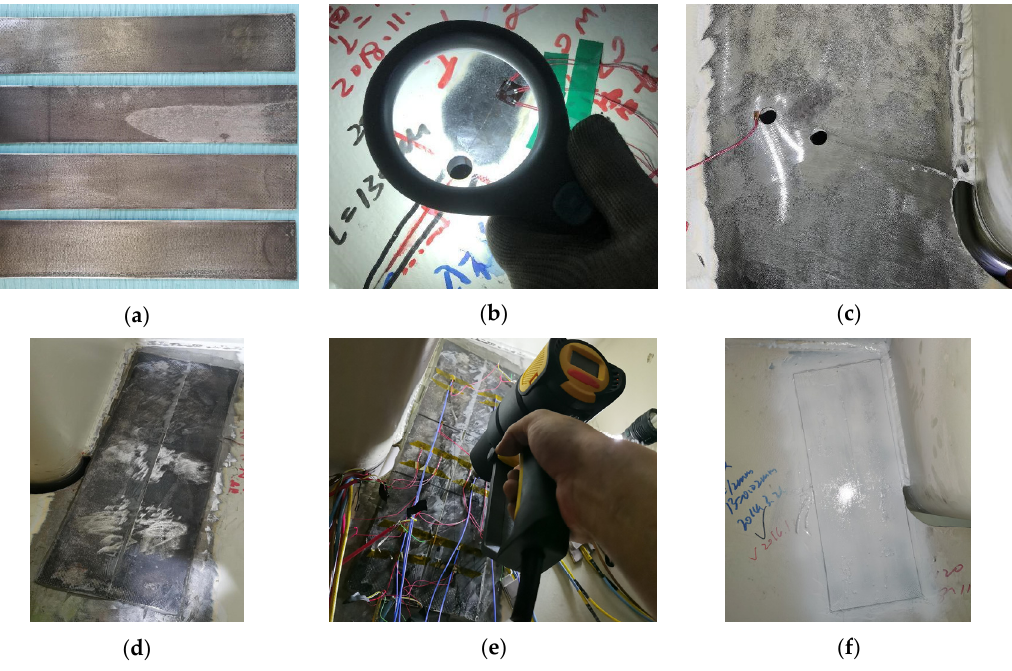
Figure 16. Repair process of the Fe-SMA plates covering crack–stop holes: ( a ) prestretch Fe-SMA plates, ( b ) locate crack tips, ( c ) polish the diaphragm, ( d ) bond the Fe-SMA plates, ( e ) activate the Fe-SMA plates, and ( f ) clean the diaphragm.